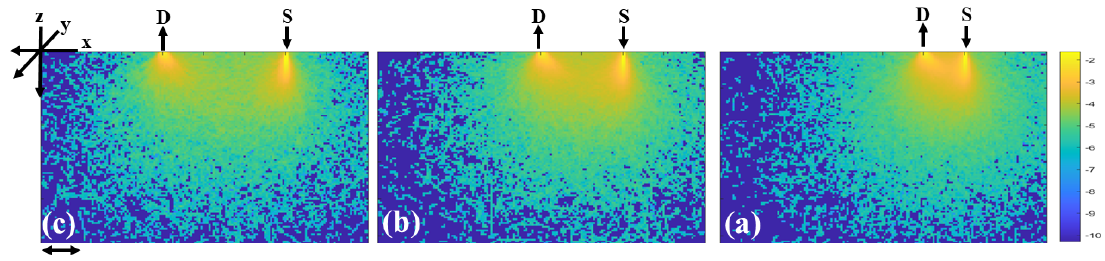
Figure 4. Spatial sensitivity profile of the photon distributions for three different source ‐ to ‐ detector separations (( a ) 2 mm, ( b ) 4 mm, and ( c ) 6 mm) for the wavelength 1050 nm. Photons follow a so ‐